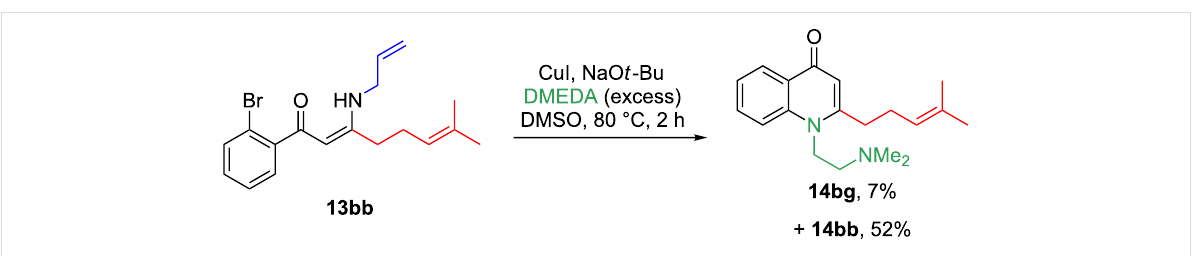
Scheme 5: Use of an excess of DMEDA in the Cu-catalysed cyclisation of 13bb resulted in the generation of 14bg as a side-product, alongside 14bb